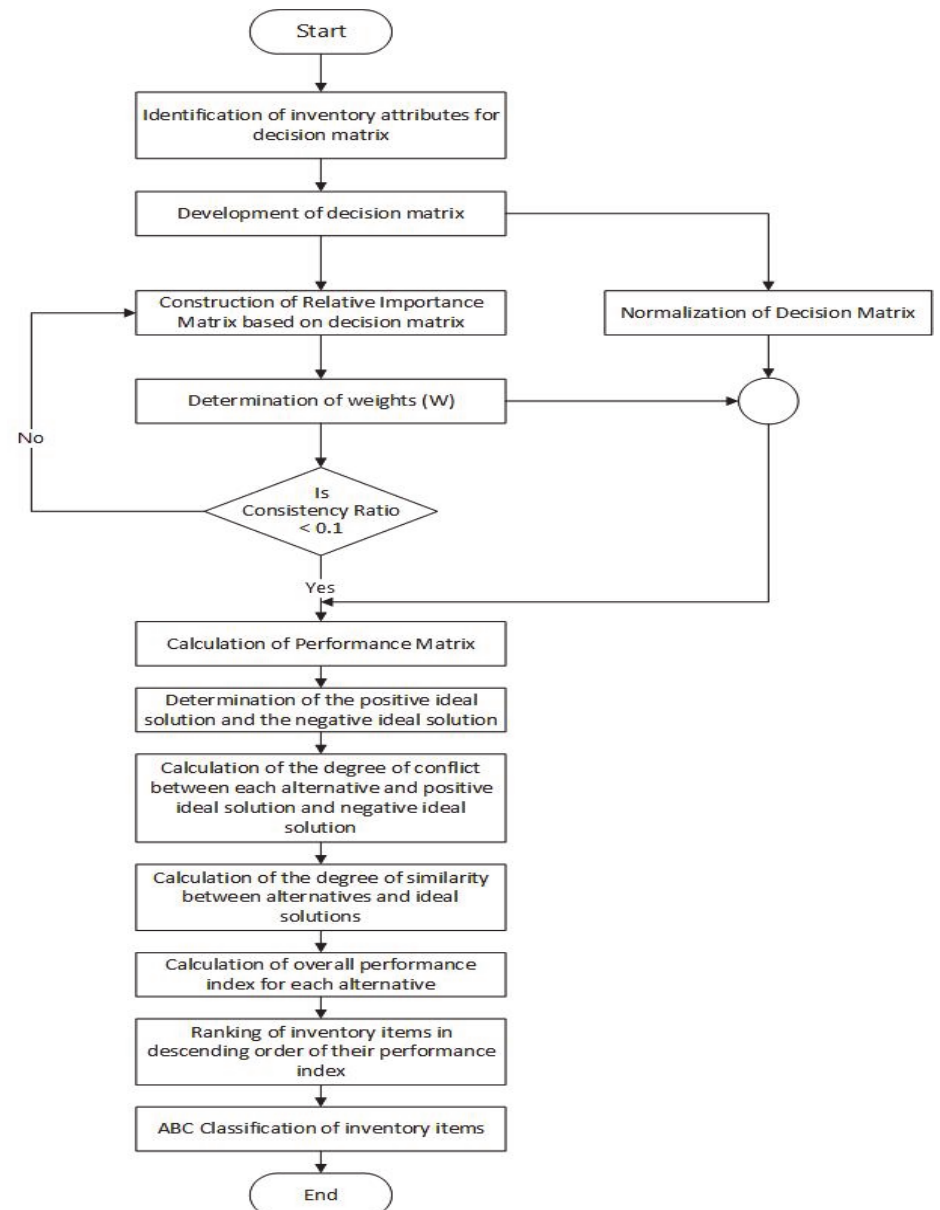
Fig. 2 indicates the procedure of the modified similarity-based method applied classifying inventory items as A, B or C.